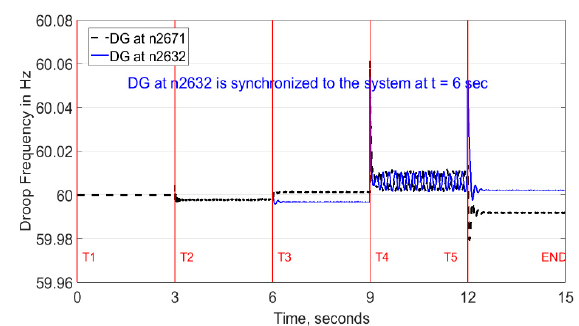
Figure 16. Droop frequency for DGs at nodes 2671 and 2632 as obtained from PSCAD simulation.